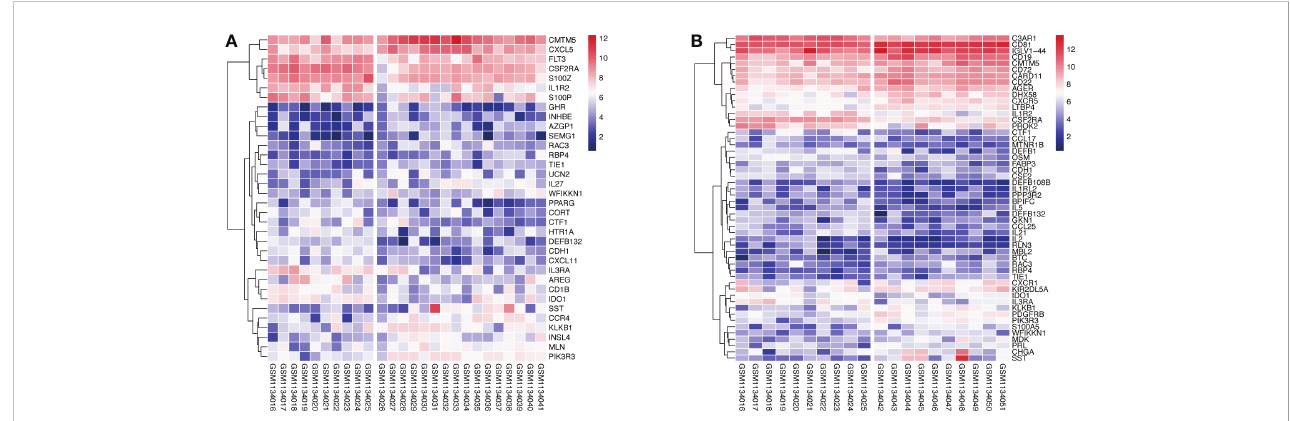
FIGURE 2 Heatmap of upregulated and downregulated genes in monosomy X TS patients compared with normal individuals. (A) Xm TS patients and normal individuals. The left side of the gap is the expression of the normal individuals, the right side is the Xm patients. (B) Xp TS patients and normal individuals. The left and right of the gap are normal individuals and Xp patients